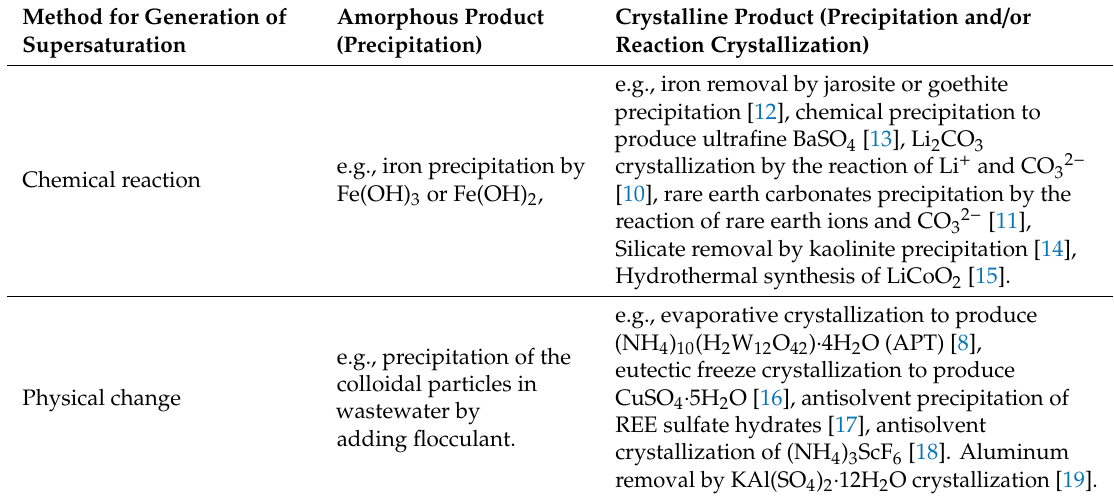
Table 1. The terminology of precipitation and crystallization under di ff erent